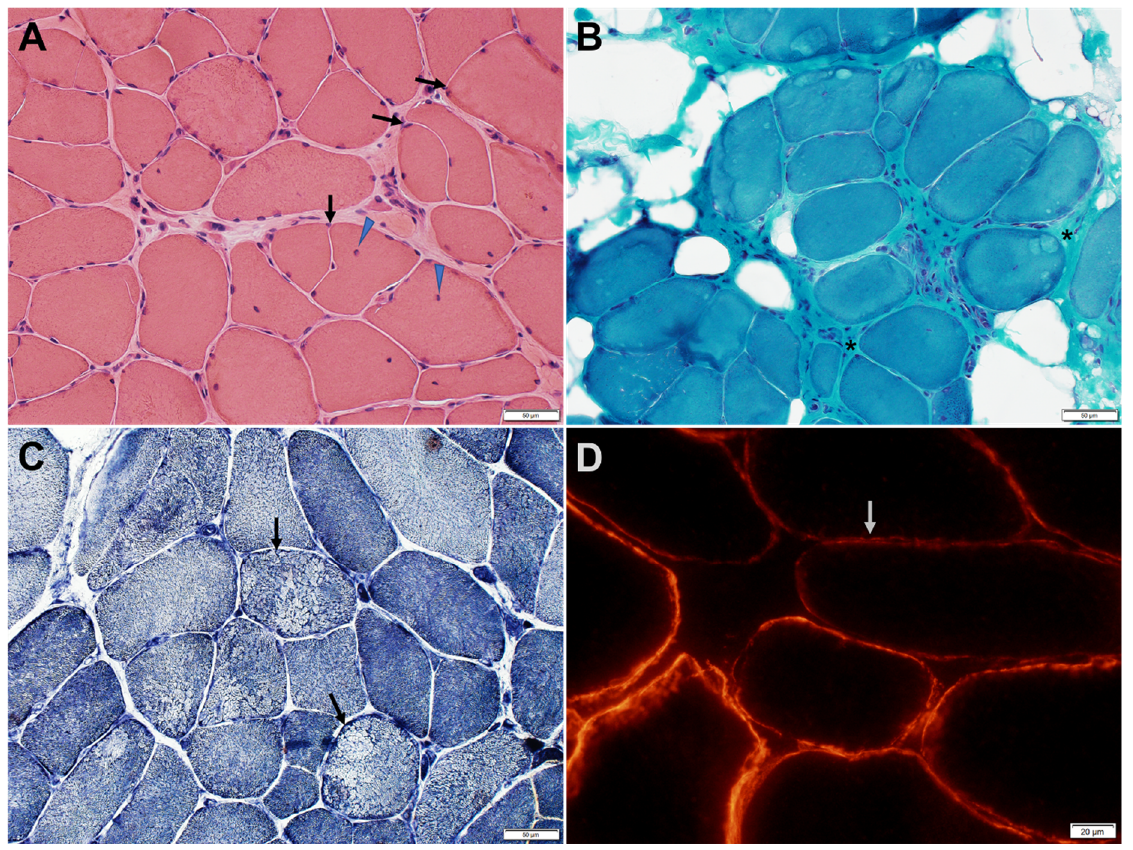
Figure 3. Muscle biopsy of a patient with GMPPB limb-girdle muscular dystrophy. ( A ) H&E-stained section shows variation in muscle fiber size, fiber splitting (arrows), and an increase in internalized nuclei (arrowheads). ( B ) Trichrome-stained section shows increased endomysial and perimysial fibrous and fatty connective tissue (asterisks). ( C ) Nicotinamide adenine dinucleotide dehydrogenase reacted section shows focal decrease of enzyme reactivity in a few fibers (arrows). ( D ) Immunohistochemical stain for α -dystroglycan shows patchy or diffuse reduction of α -dystroglycan immunoreactivity (arrow shows a representative fiber) at the sarcolemma of many muscle fibers.